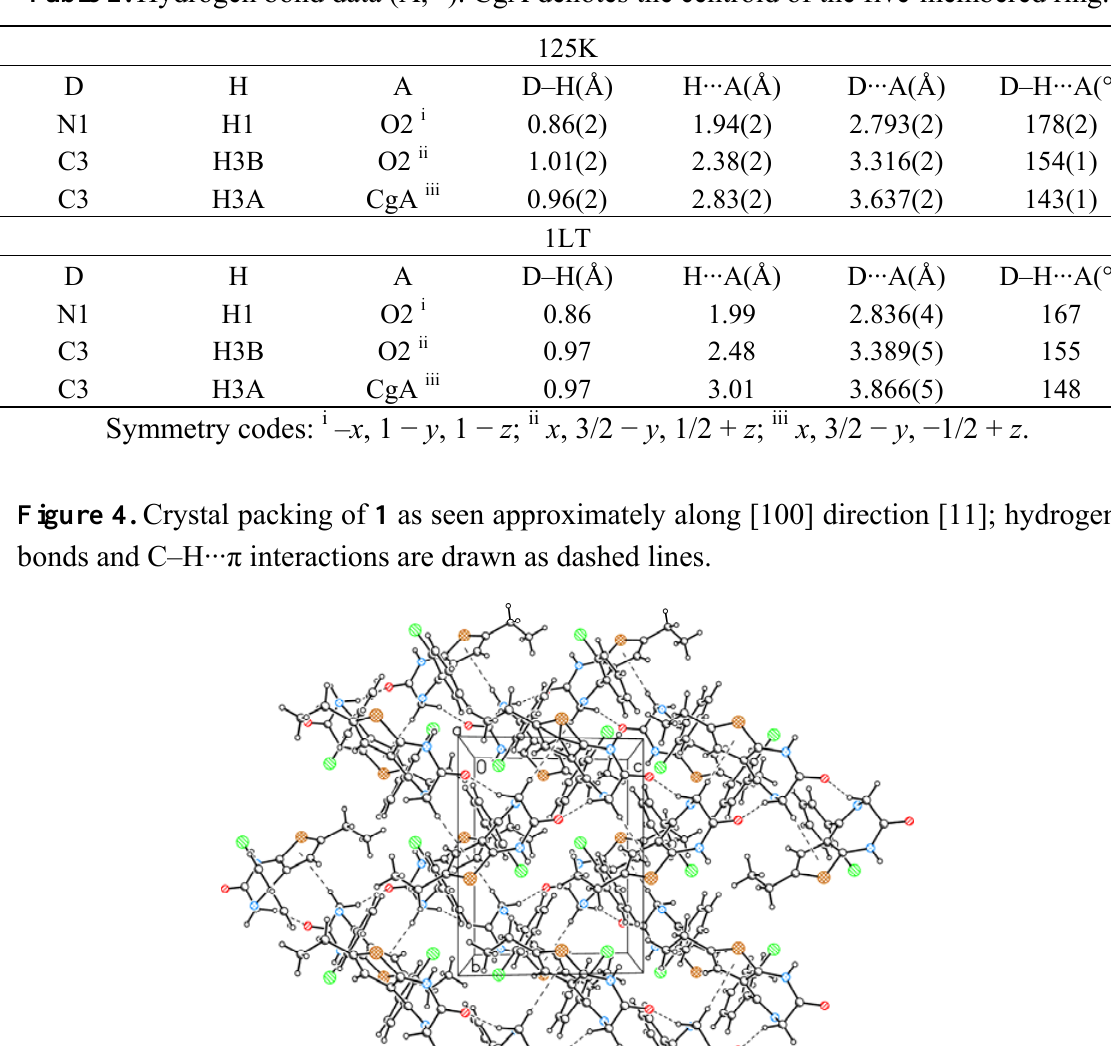
(8) dimer of molecules 1 [11]. Hydrogen bonds are shown 2